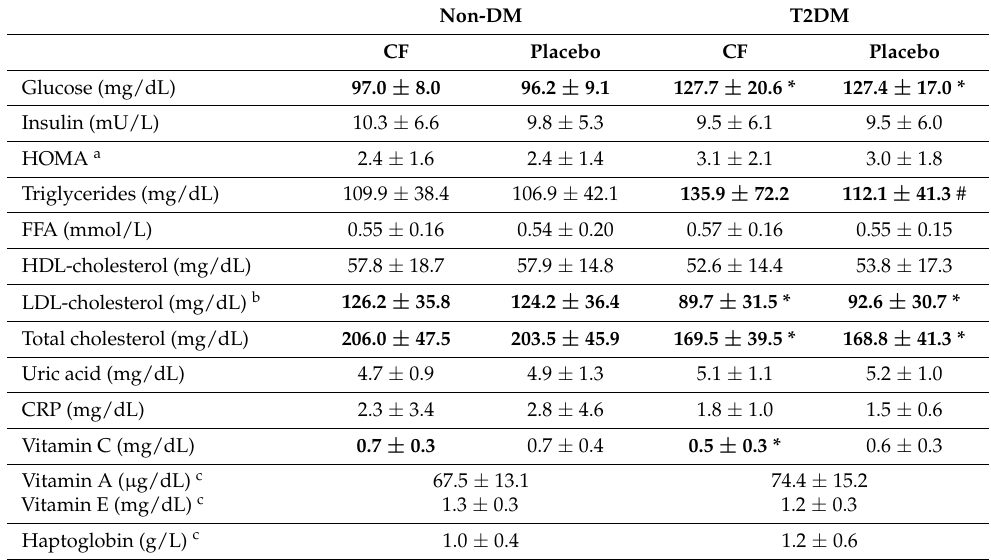
Table 2. Fasting blood results.